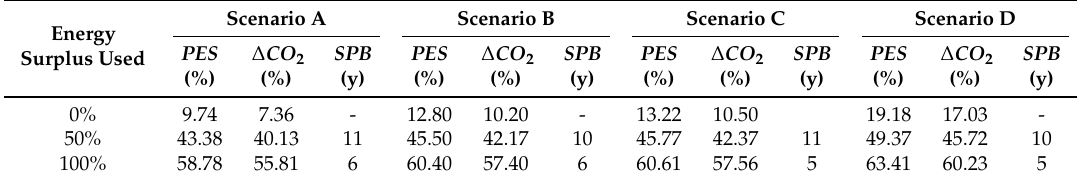
Table 7. Best energy, environmental and economic results with flat-plate collectors.